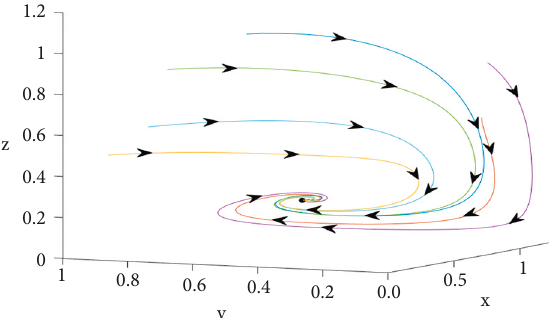
Figure 2: Case 1: the phase diagrams for system (92) at τ